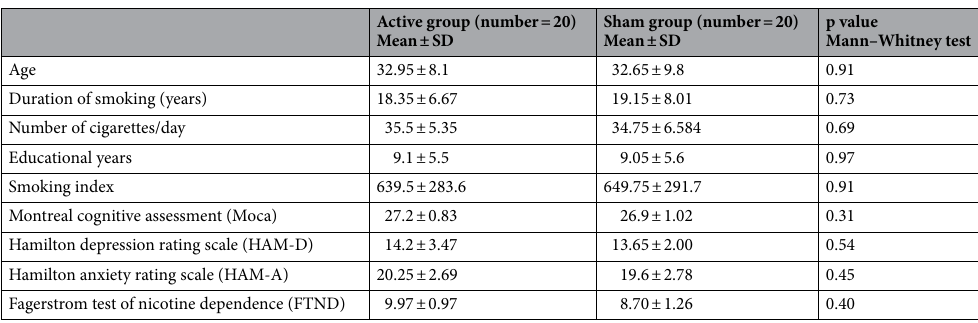
Table 1. Demographic and clinical data of the studied